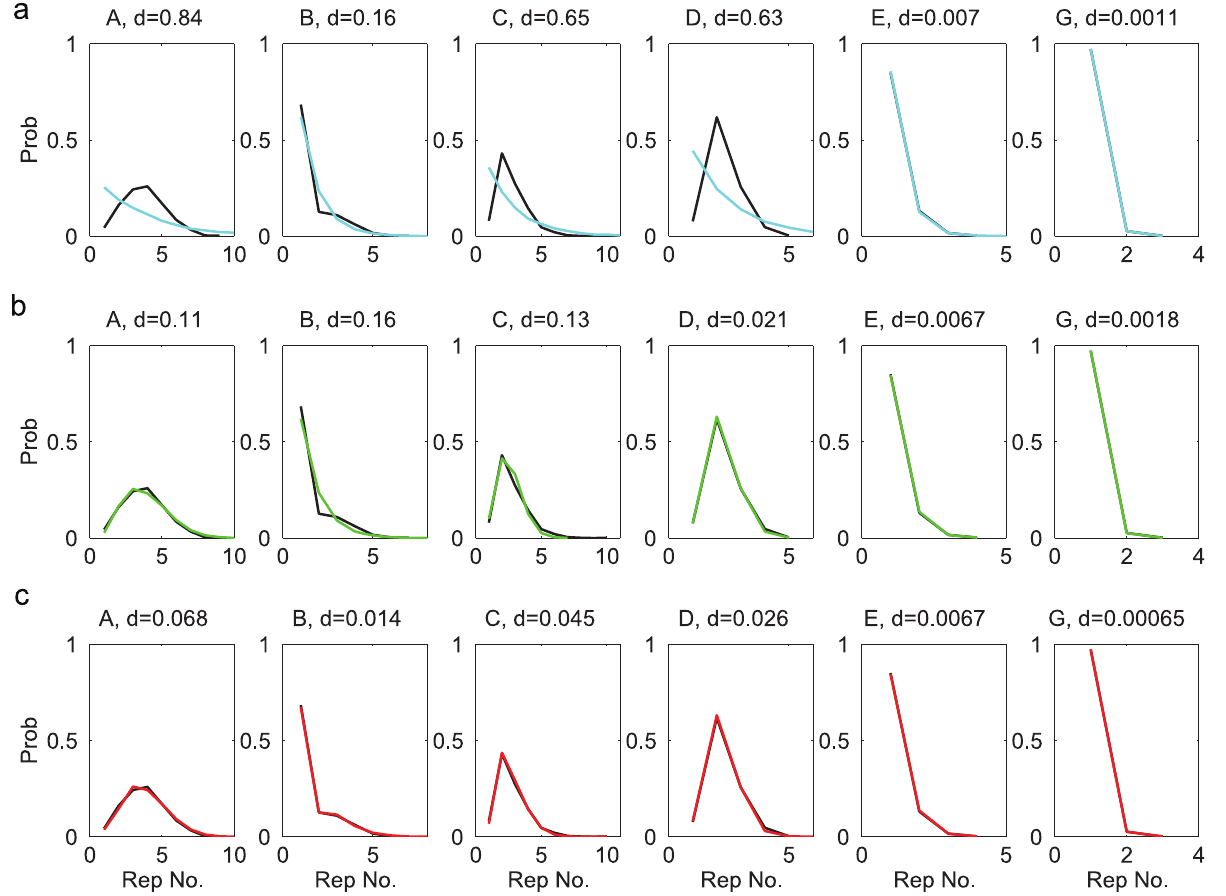
Figure 3. Comparisons of the repeat distributions for syllables A,B,C,D,E,G (Bird 1). The black curve in each graph is from the observed syllable sequences. a . Comparison to the distributions from the Markov model (cyan curves). b . Comparison to the distributions from the Markov model with adaptation (green curves). c . Comparison to the distributions from the POMMA (red curves). The differences between the model and the observed curves are indicated with the d -values above each graph.